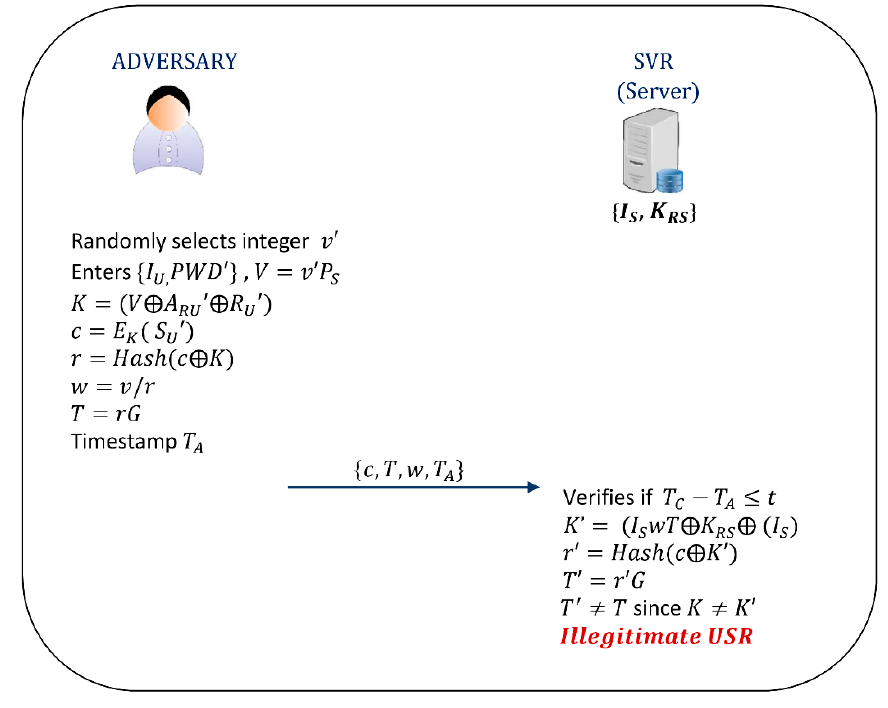
Figure 7. Resistance to user impersonation in ECSSP-SC.